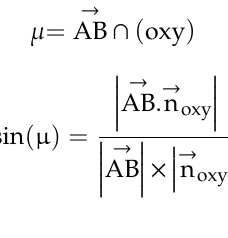
Figure 6. Center shift scenario. Then, the coordinates of the intersection point, E, from the intersection between the expectation distance line and the line between the two LEDs in the LED plane are calculated by Equation (15).